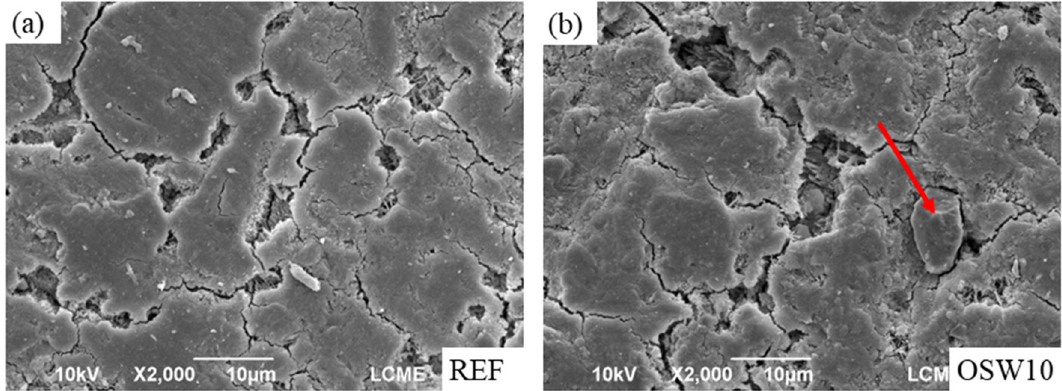
Figure 12. SEM images of ( a ) the REF paste and ( b ) the OSW10 paste.